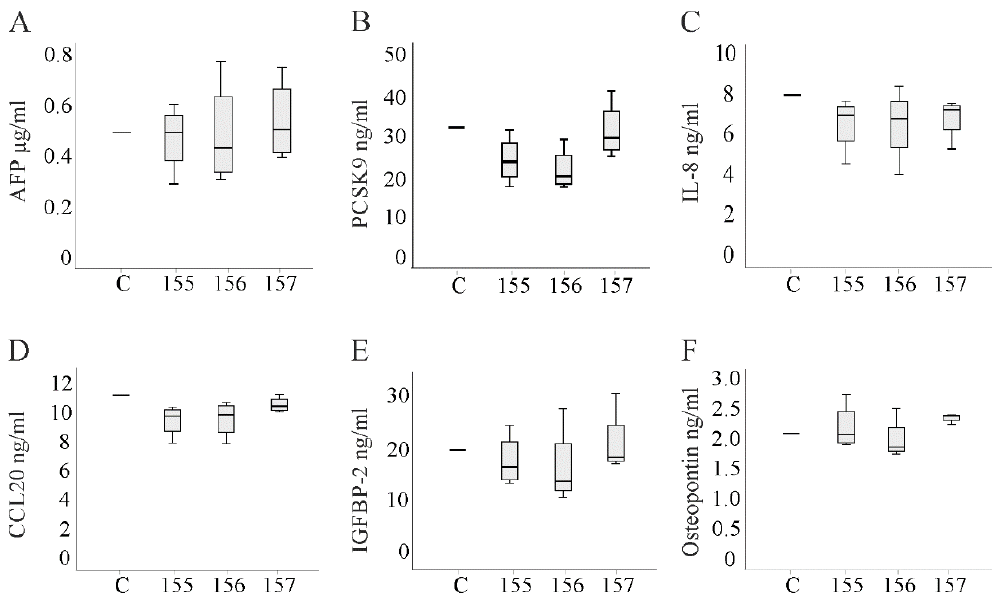
Figure 7. Proteins measured in the media of transfected Huh7 cells by ELISA. ( A ) Alpha-fetoprotein (AFP); ( B ) proprotein convertase subtilisin / kexin type 9 (PCSK9); ( C ) IL-8; ( D ) CCL20; ( E ) insulin-like growth factor-binding protein-2 (IGFBP-2); ( F ) osteopontin. n = 4. Data were analyzed with one-way ANOVA with post-hoc Tukey test or the Welch test with post-hoc Games– Howell test.